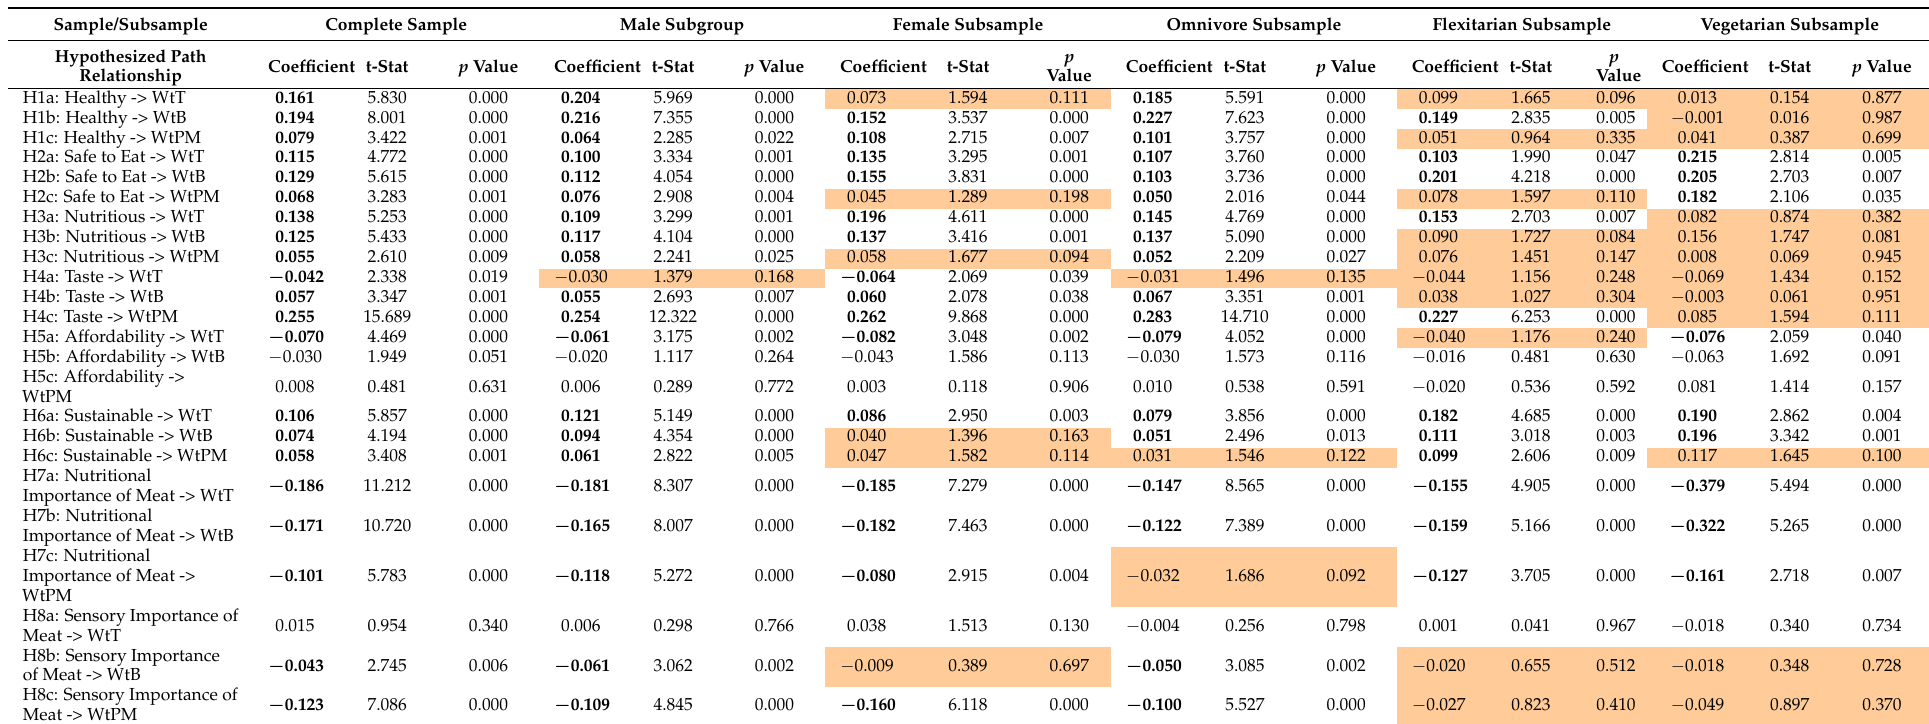
Table 6. Results of Hypothesis